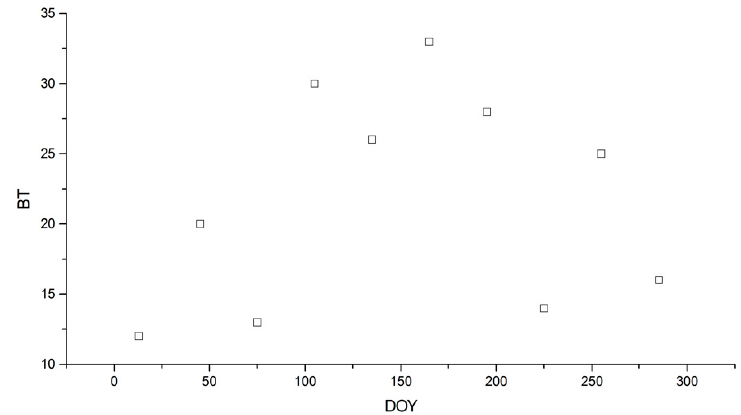
Figure A1. Scatter diagram of BT.